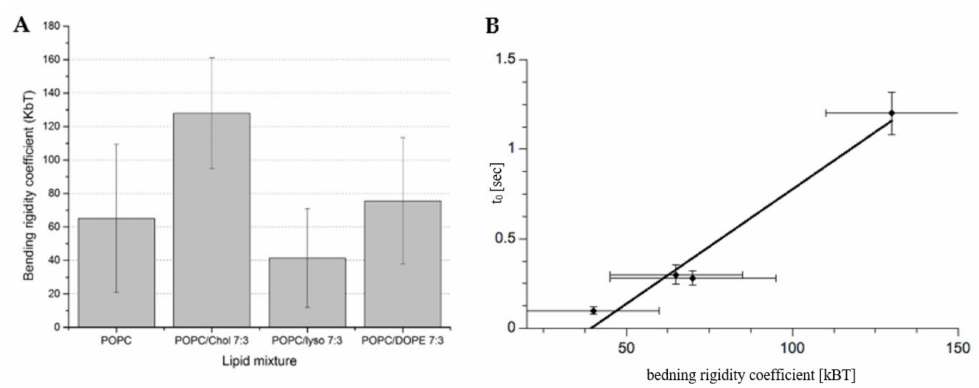
ference (Figure 3—1/ ∆Π = 0.05 mOsm-1). Values on the x-axis of the plot were calculated bending rigidity coefficient shown in Figure 7A.